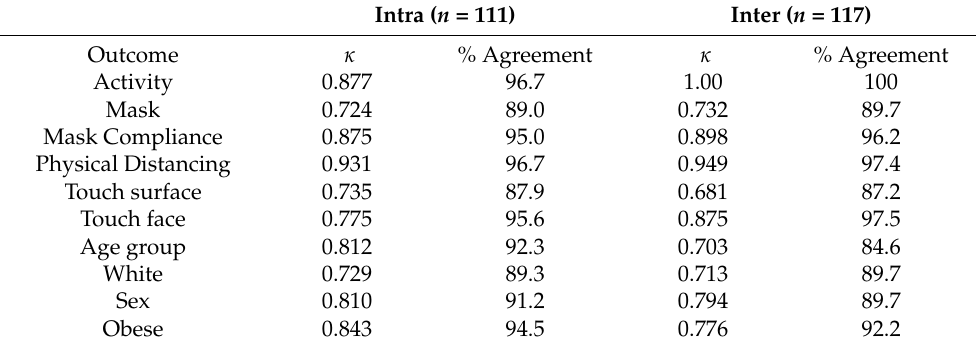
Table 3. Intra- and inter-reviewer reliability for presence/absence of characteristics.